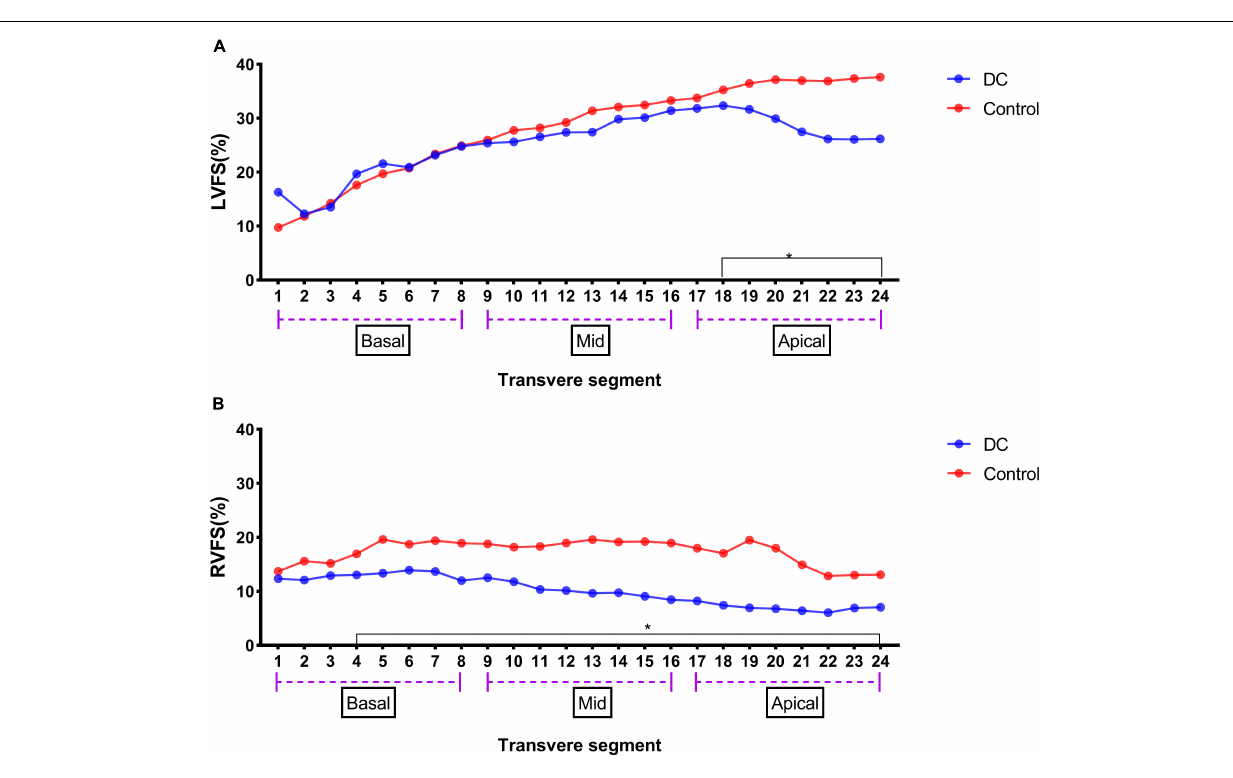
Frontiers in Cardiovascular Medicine |